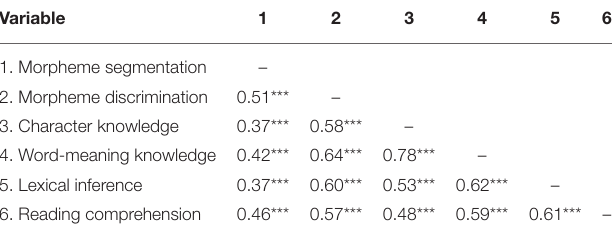
TABLE 2 | Bivariate correlations among morphological awareness, vocabulary knowledge, lexical inference, and reading comprehension.